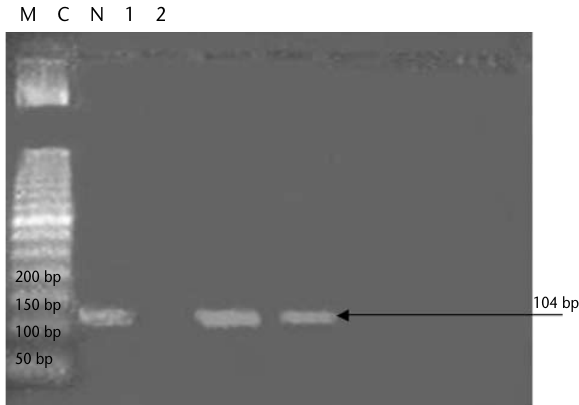
Figure – PCR amplification of the two PB19 infected placentas. M: DNA ladder; C: positive control; N: negative control; 1: case one; 2: case